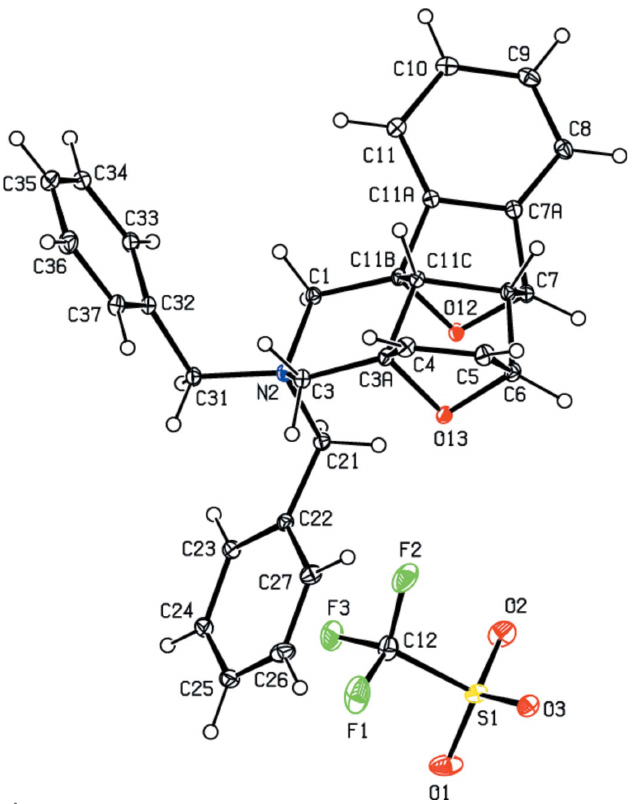
Figure 2 The asymmetric unit of the title salt 1 with displacement ellipsoids for the non-hydrogen atoms drawn at the 30% probability level.